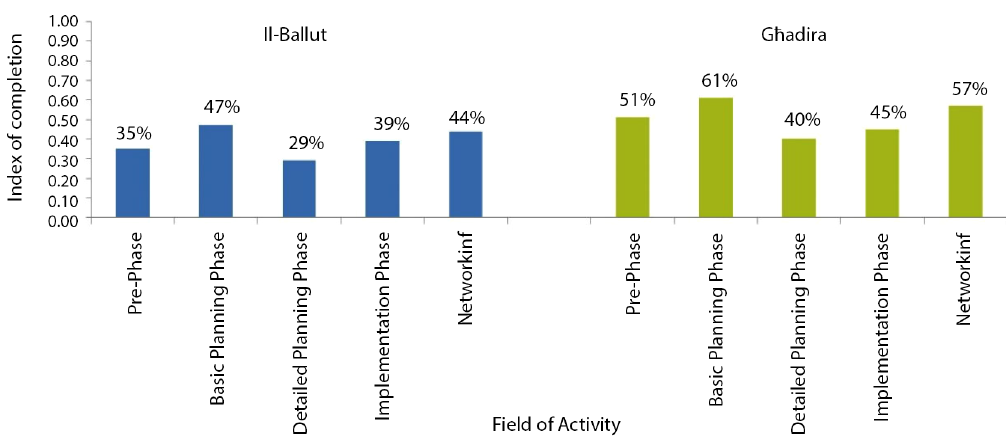
Figure 7. Comparison of management effectiveness of selected wetlands in each phase of the PA life-cycle